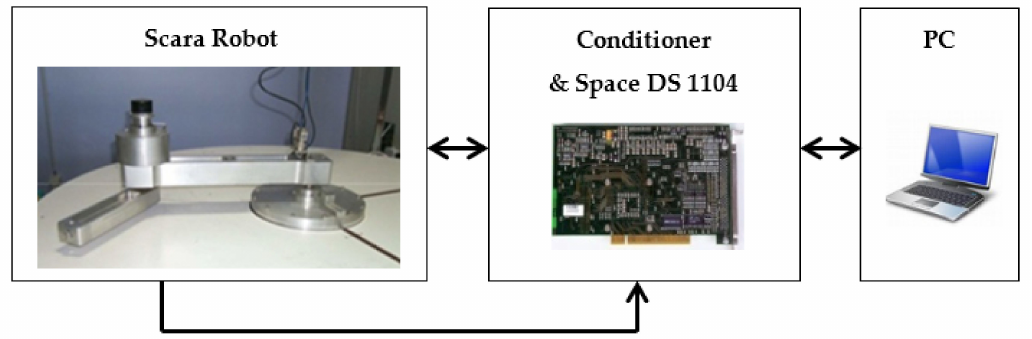
Figure 2. System application: Robot SCARA with